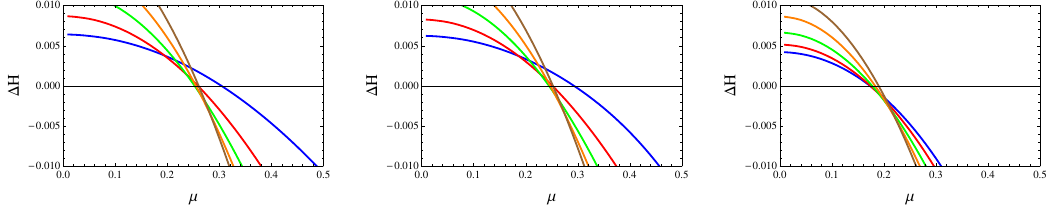
Figure 6 . Di(cid:11)erence of ground state Hamiltonians (cid:1) H as a function of (cid:22) and di(cid:11)erent values of the magnetic (cid:12)eld b = 0 : 05 (blue), b = 0 : 1 (red), b = 0 : 15 (green), b = 0 : 2 (orange) and b = 0 : 25 (brown). The left, center and right panels correspond to v T = 0, v T = 0 : 1 and v T = 0 : 3, respectively.